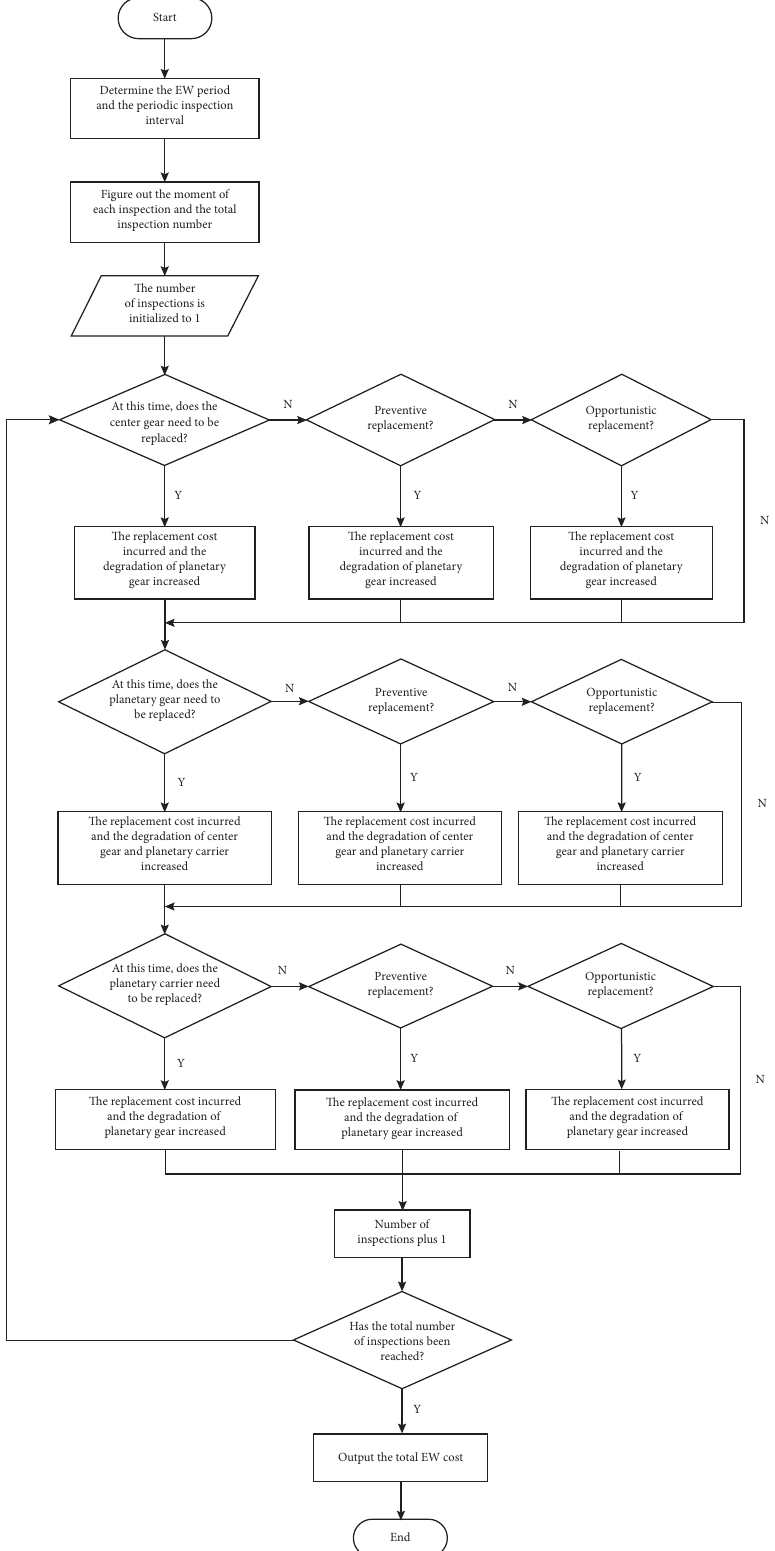
Figure 8: The flowchart of Monte Carlo